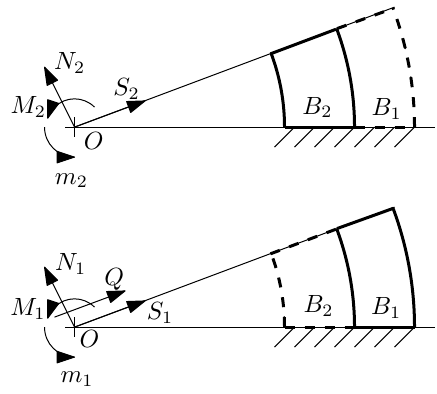
Figure 3: Illustration of internal forces and